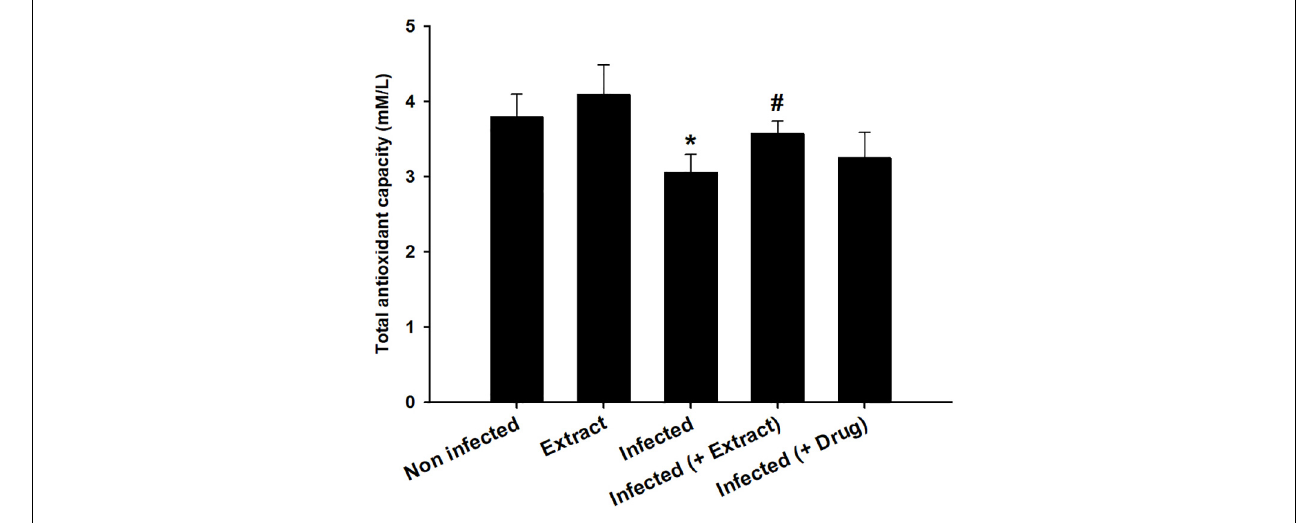
using FTIR showed strong peaks at 1,712.46, 1,615.19, 1,514.50,